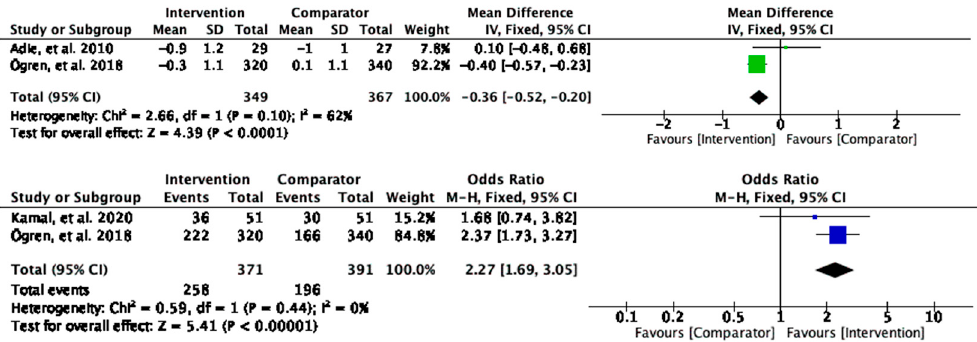
Figure 6. Meta-analysis results of LDL-C outcomes.